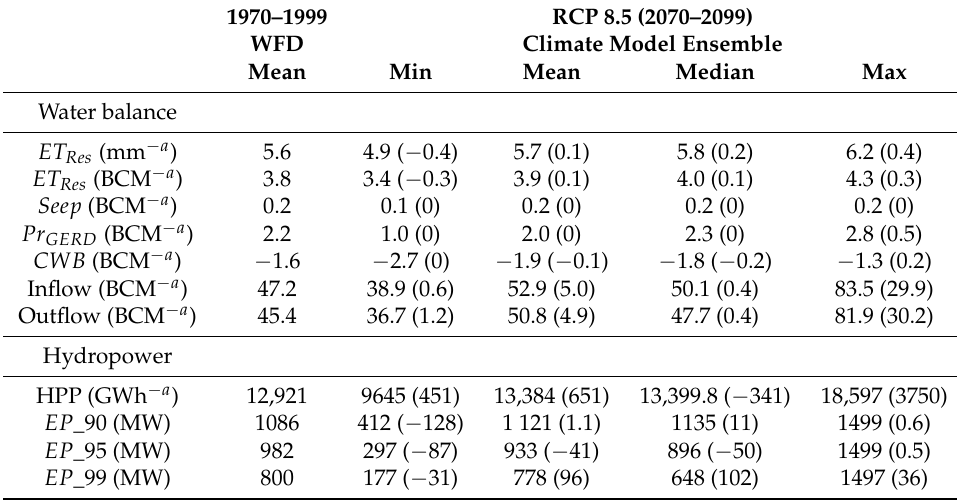
Table 5. Reservoir statistics comparison for WFD and model ensemble,